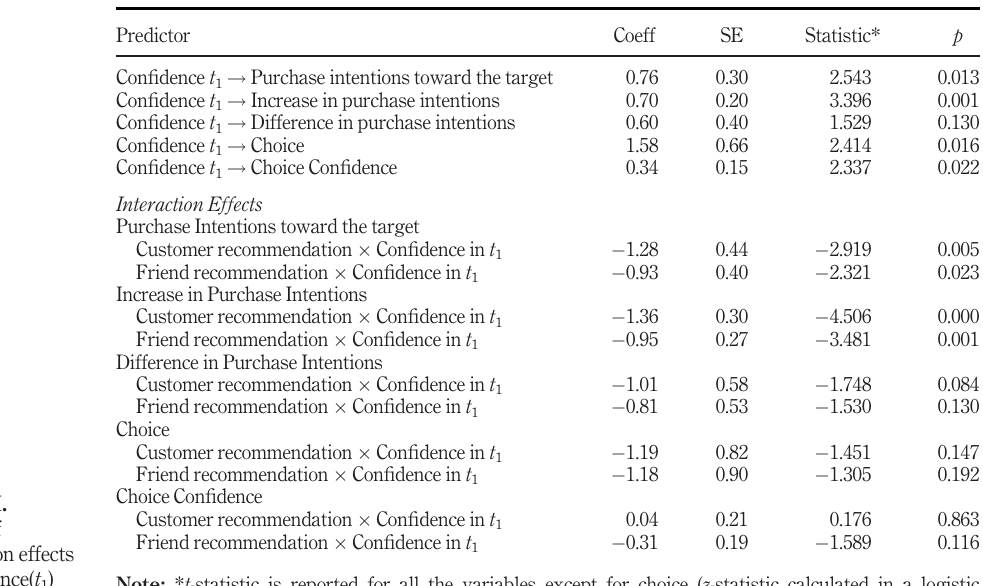
Table III. Results of moderation effects of con fi dence( t 1